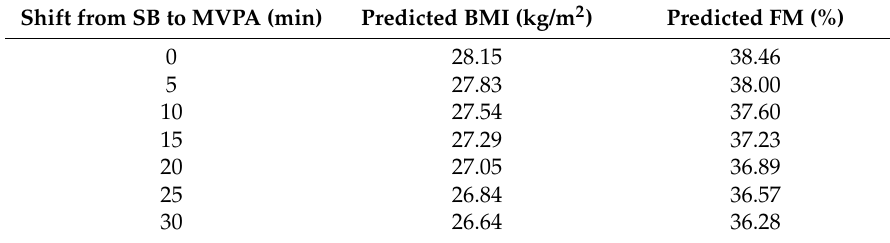
Table 4. Estimated BMI and FM% when reallocating between 0 and 30 min from SB to MVPA. Shift from SB to MVPA (min) Predicted BMI (kg/m 2 ) Predicted FM (%) 0